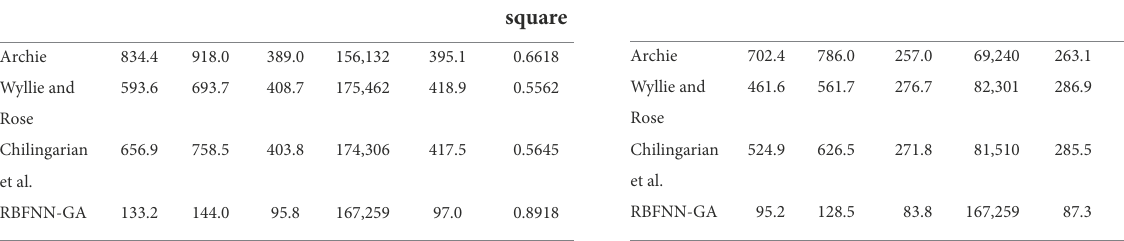
TABLE 1 Determining the static error parameters for predicting k for the training subset. Models